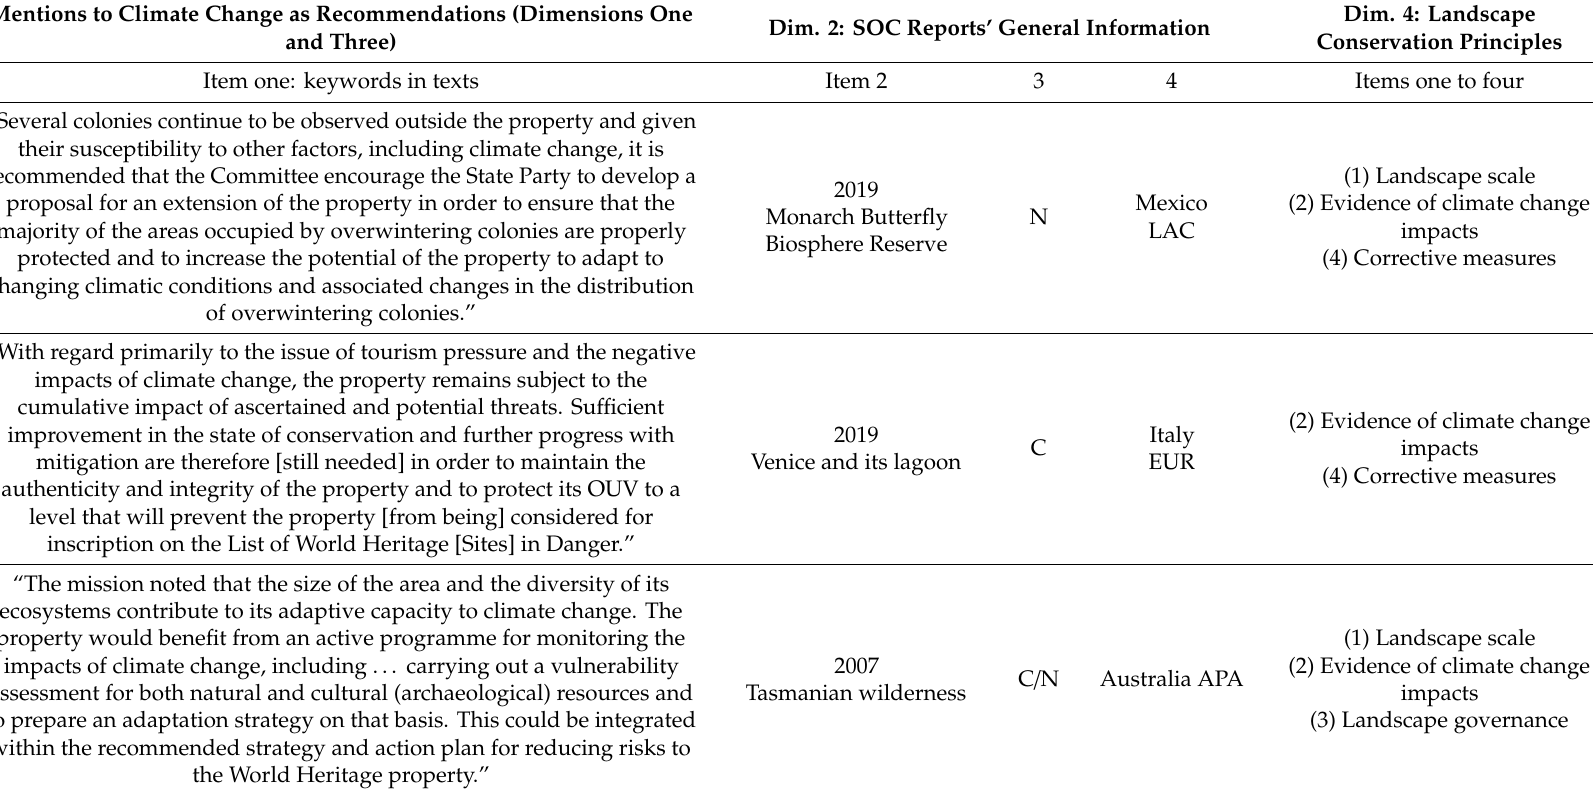
Table 4. Example of analysis recommendations (item 3.3) and landscape conservation principles (dimension